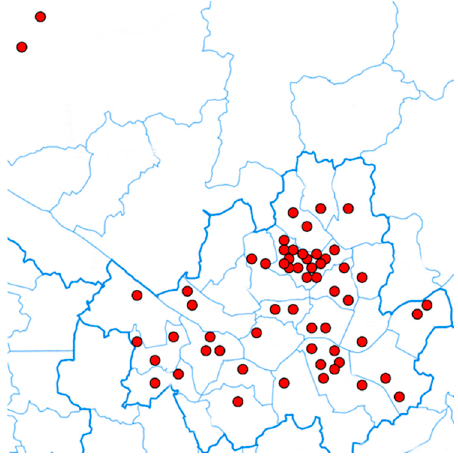
Figure 2. Location of carsharing stations (red makers) separated by district area around Seoul.